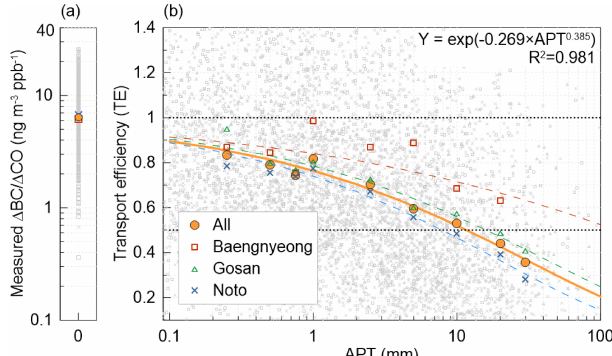
Figure 2. Measured (cid:49) BC /(cid:49) CO ratios, when accumulated precip- itation along trajectory (APT) was zero (a) and transport efficiency (TE) variation was a function of APT (b) , depending on the differ- ent sites and overall cases. All data (gray with different symbols) and nine bins sorted by APT (different colored symbols) are shown. The horizontal dotted lines indicate TE at 0.5 and 1,